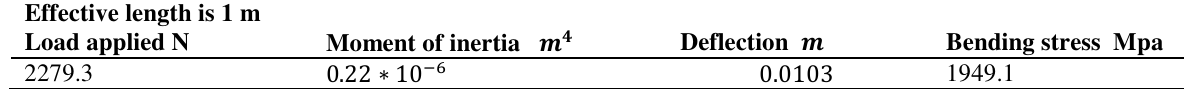
Calculations for 50cm specimens Effective length is 0.5 m Load applied